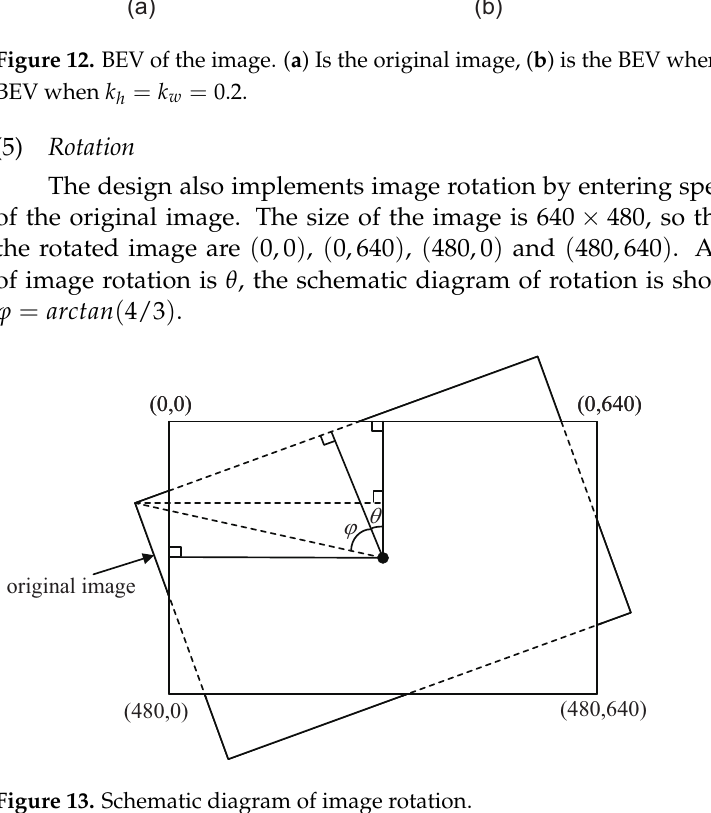
Figure 13. Schematic diagram of image